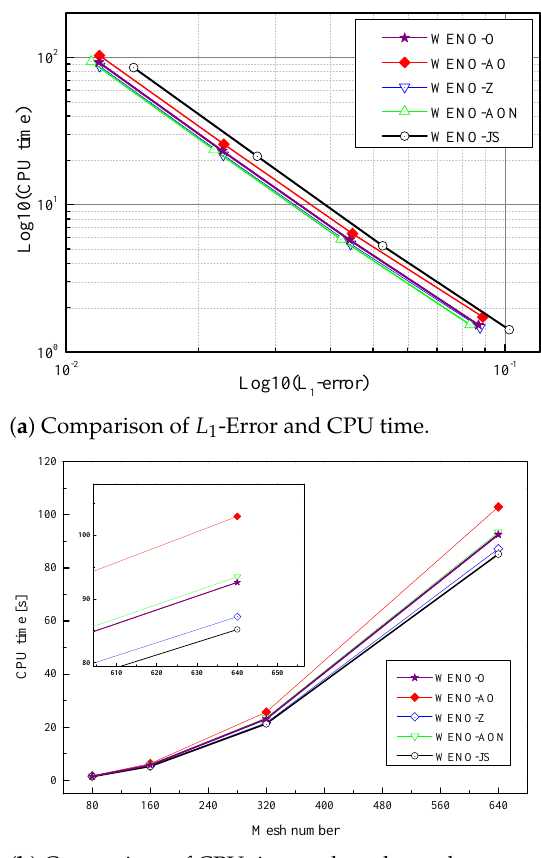
Figure 14. The accuracy comparison of considered WENO schemes for Sod’s problem of Example 5 (Section 6.2.2) for density field at time t = 2, CFL = 0.1.